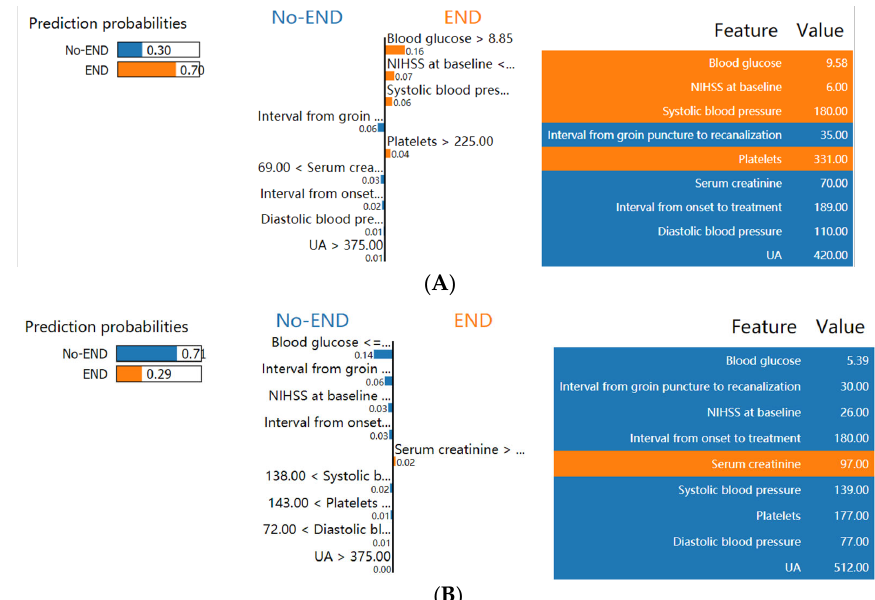
Figure 5. LIME plot for individual case explanation on two random patients from the testing set of the XGBoost model. LIME plot included the patient from the “true positive” group explained by LIME algorithm ( A ) and a patient from the “true negative” group explained by LIME algorithm ( B ).